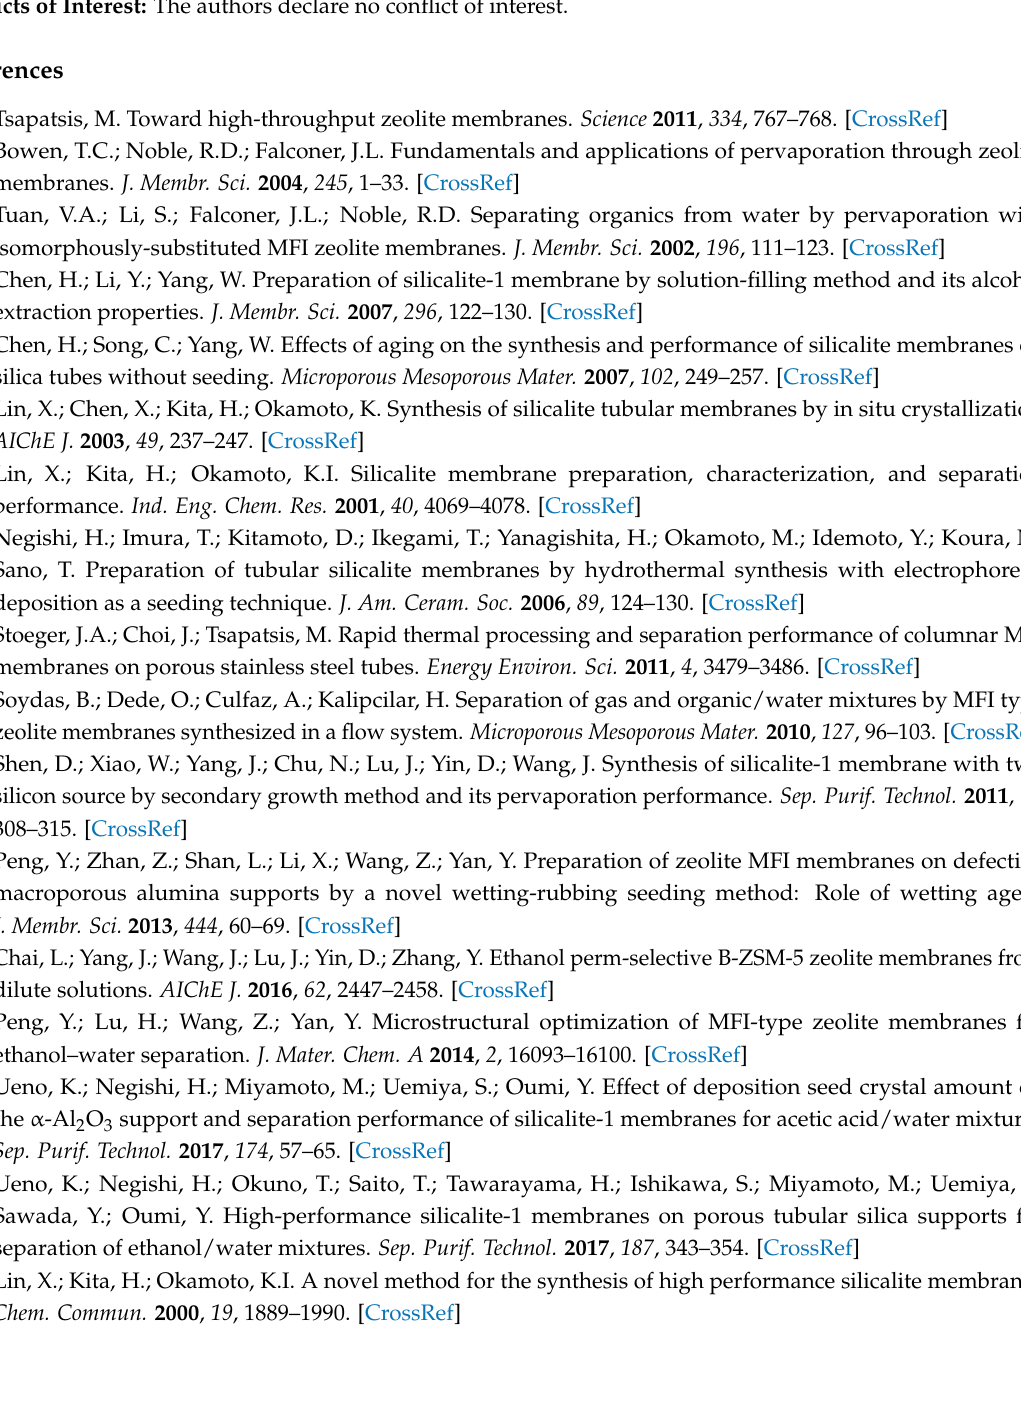
Figure S1: SEM image of silicalite-1 membrane fabricated by the gel-free SAC method using uncoated silica support; Figure S2: XRD patterns of obtained products prepared by the gel-free SAC method for different synthesis times using unseeded uncoated silica support; Figure S3: SEM images of obtained products prepared by the gel-free SAC method for different synthesis times using unseeded uncoated silica